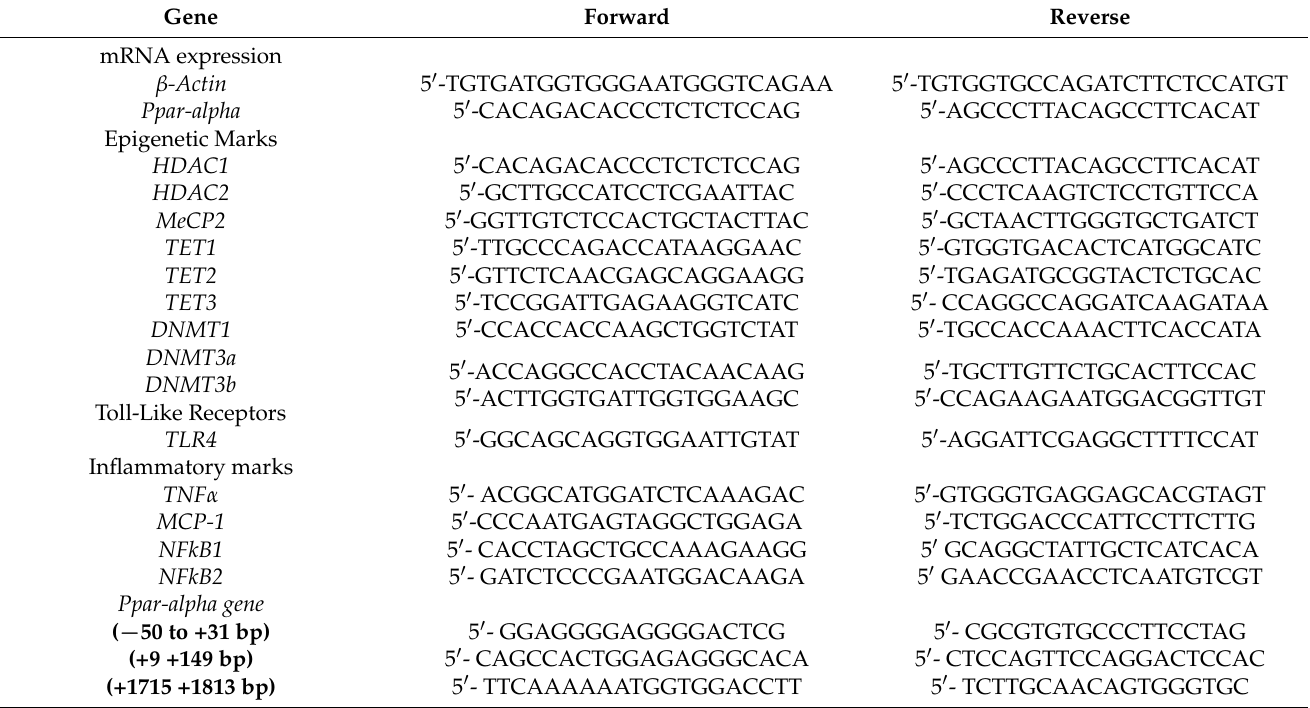
are listed in Table 1. The relative mRNA expression values were calculated as the fold of controls using β -Actin as the internal control for sample normalization. Table 1. Primer sequences for qPCR